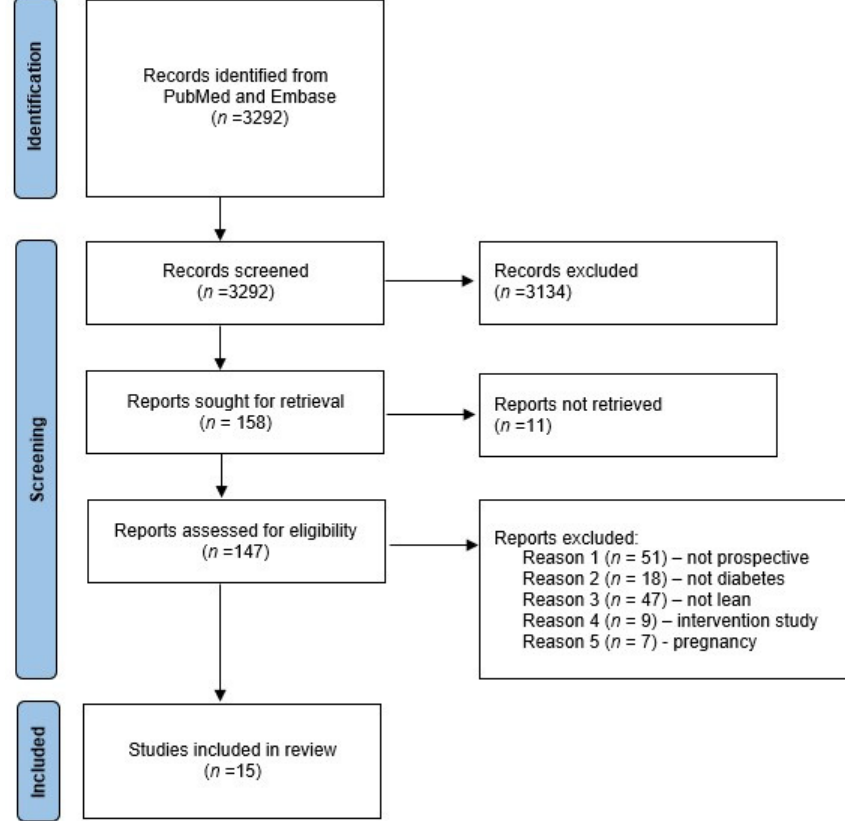
Figure 1. PRISMA flow chart of included studies regarding prospective risk of T2D in normal weight women with